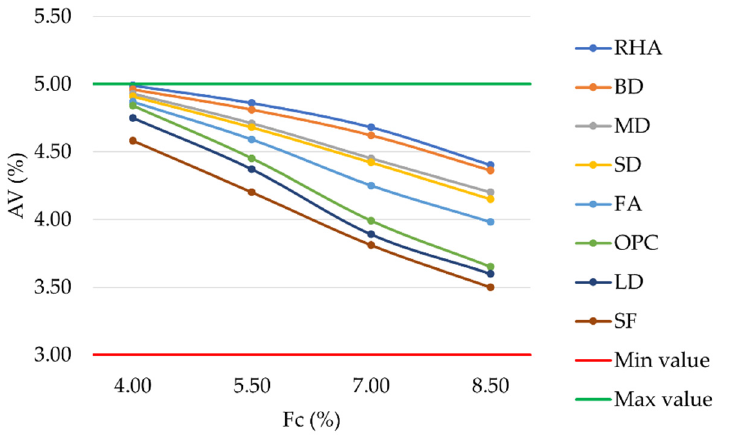
Figure 4. Air voids vs. filler content for mixtures prepared with conventional and waste fillers.